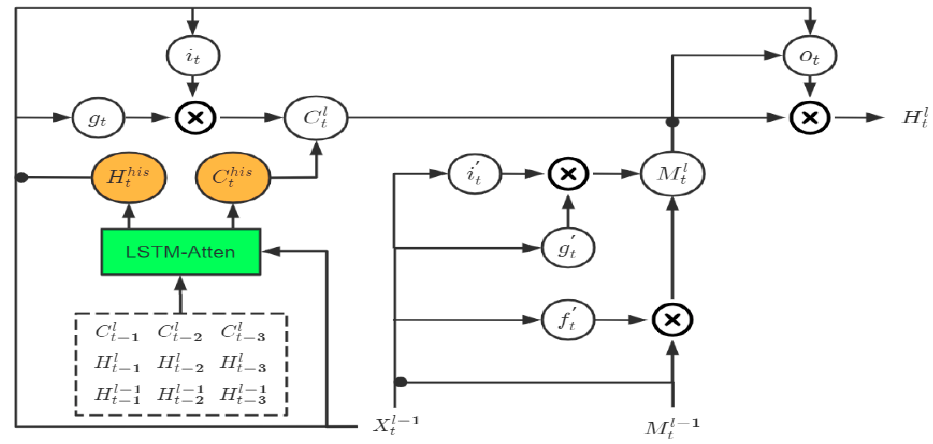
Figure 5. Proposed GA-LSTM block.